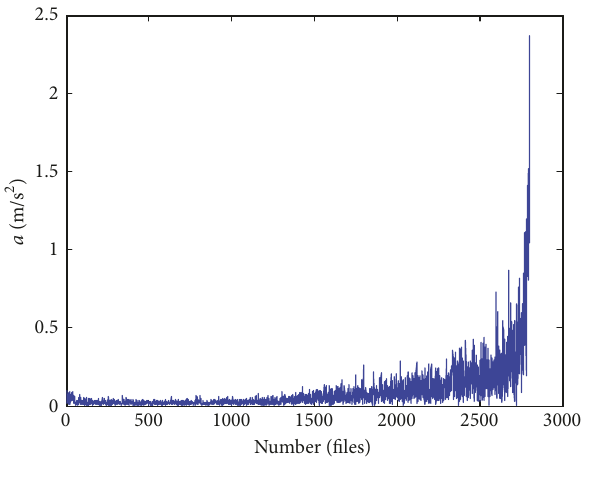
Figure 15: The ADF of the Bearing1 1.